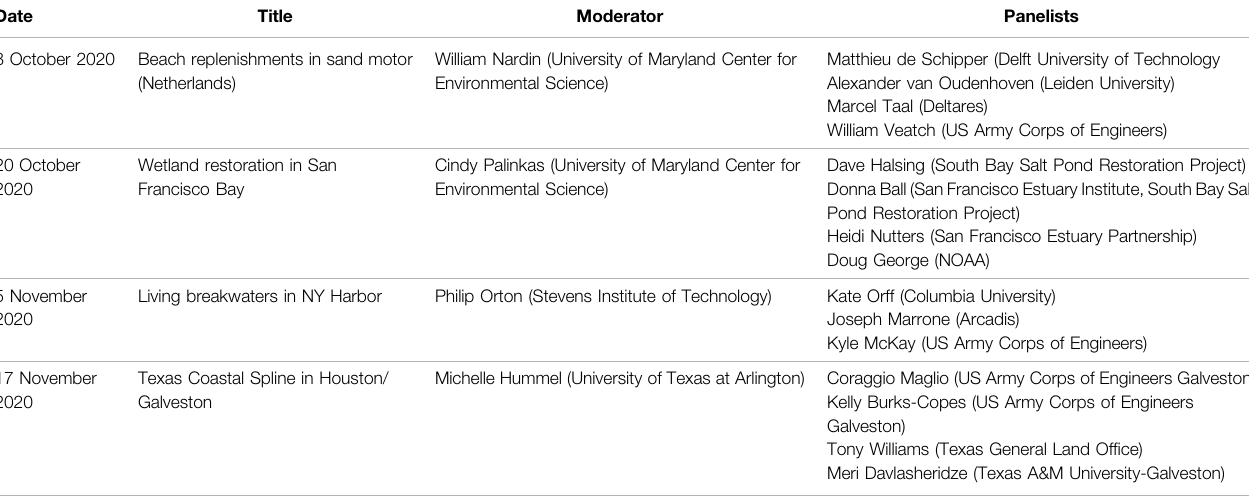
TABLE 1| SteeringCommitteeMembers:CindyPalinkas[University ofMarylandCenterforEnvironmental Science(UMCES)]; PhilipOrton(Stevens Institute ofTechnology); Michelle Hummel (University of Texas at Arlington); William Nardin, Matthew Gray, Ming Li, Lora Harris (UMCES); Ariana Sutton-Greir (University of Maryland College Park).